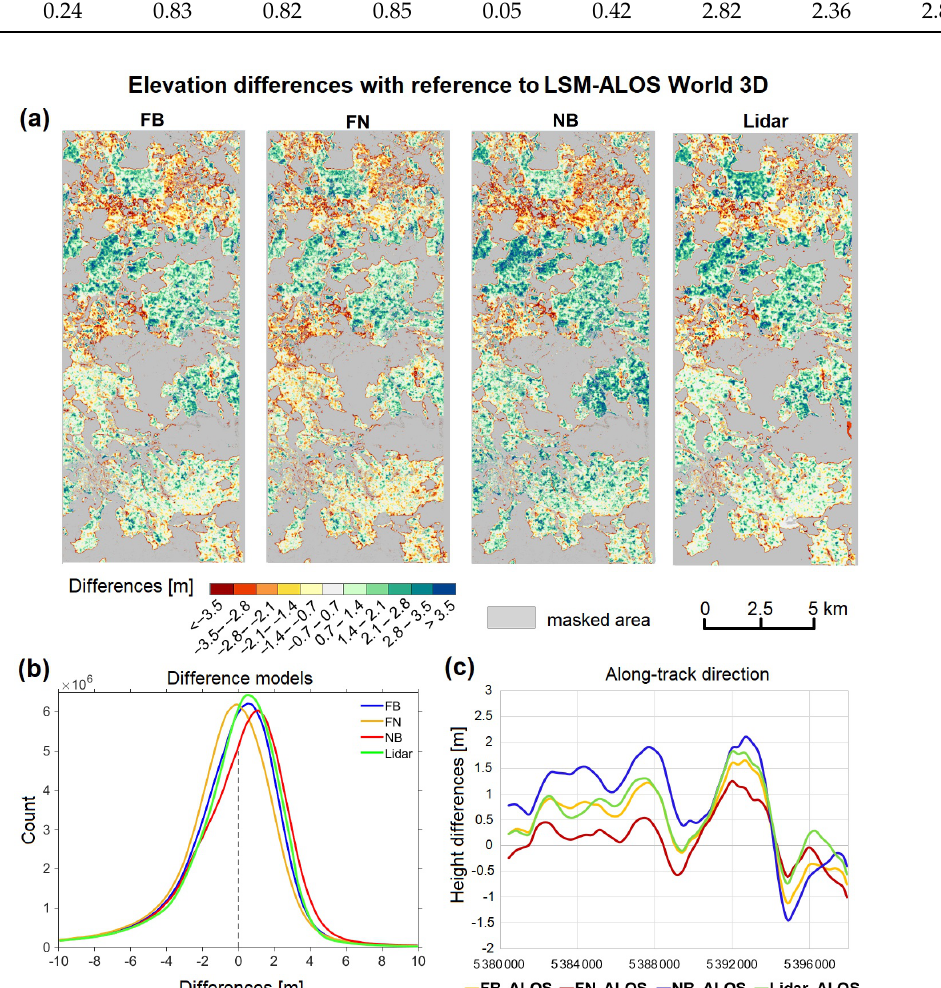
Figure A1. Elevation differences (Pléiades DEMs and Lidar DTM) with respect to LSM ALOS World 3D reference: ( a ) Color coded height difference models (masked areas are shown in grey). ( b ) Frequency distribution of height discrepancies for all combinations. ( c ) Section profile in along- track direction with Z elevation differences of pairwise DSMs against reference LSM-ALOS World